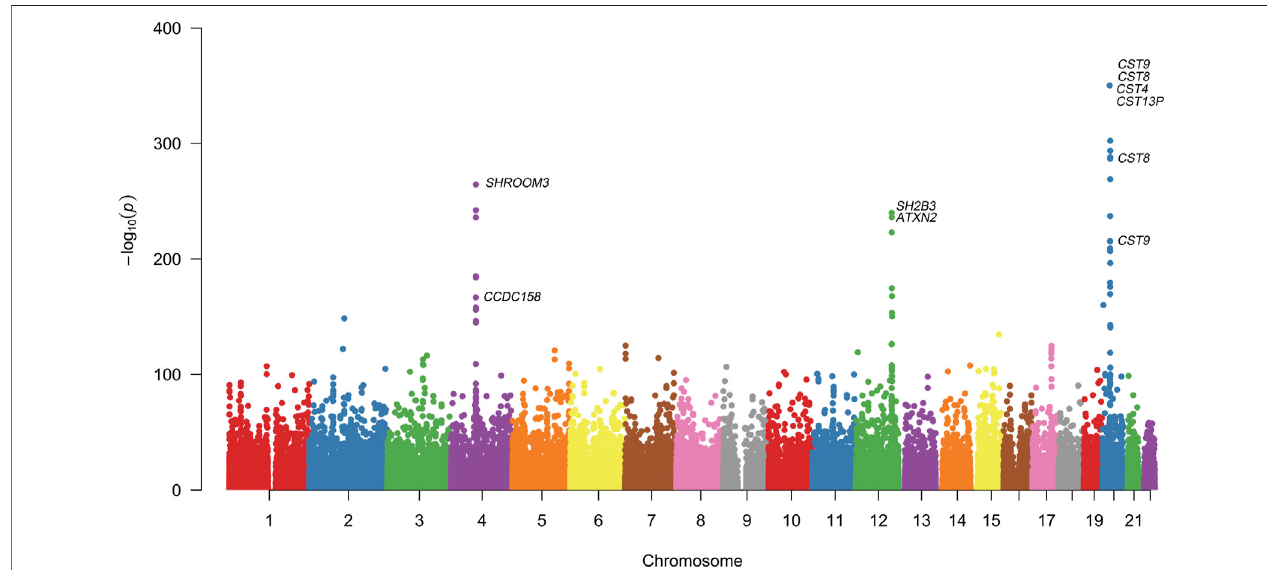
FIGURE 1 | Manhattan Plot for genome wide association study of cystatin C. Variants are positioned according to the GRCh37 genome reference sequence. Associations with p -value < 1 × 10 − 308 were not displayed in normal scale.